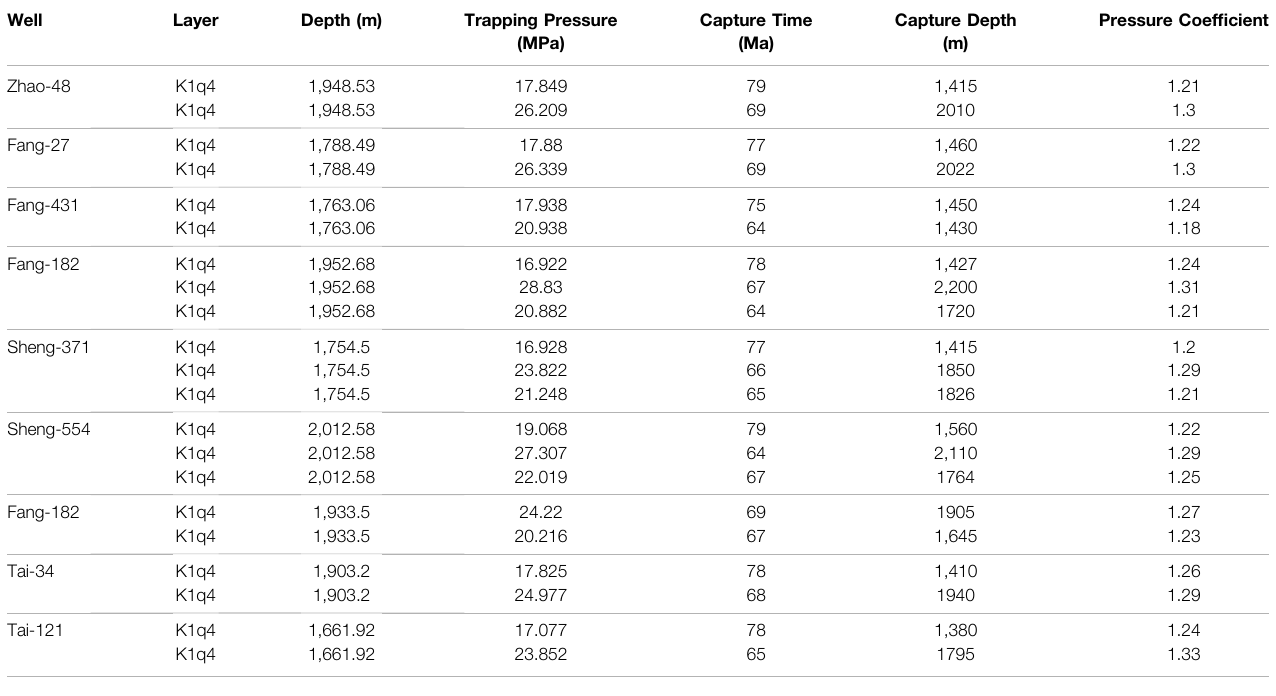
TABLE 3 | Reservoir formation period and paleo-pressure in the Fuyu oil reservoir of the Sanzhao area. Well